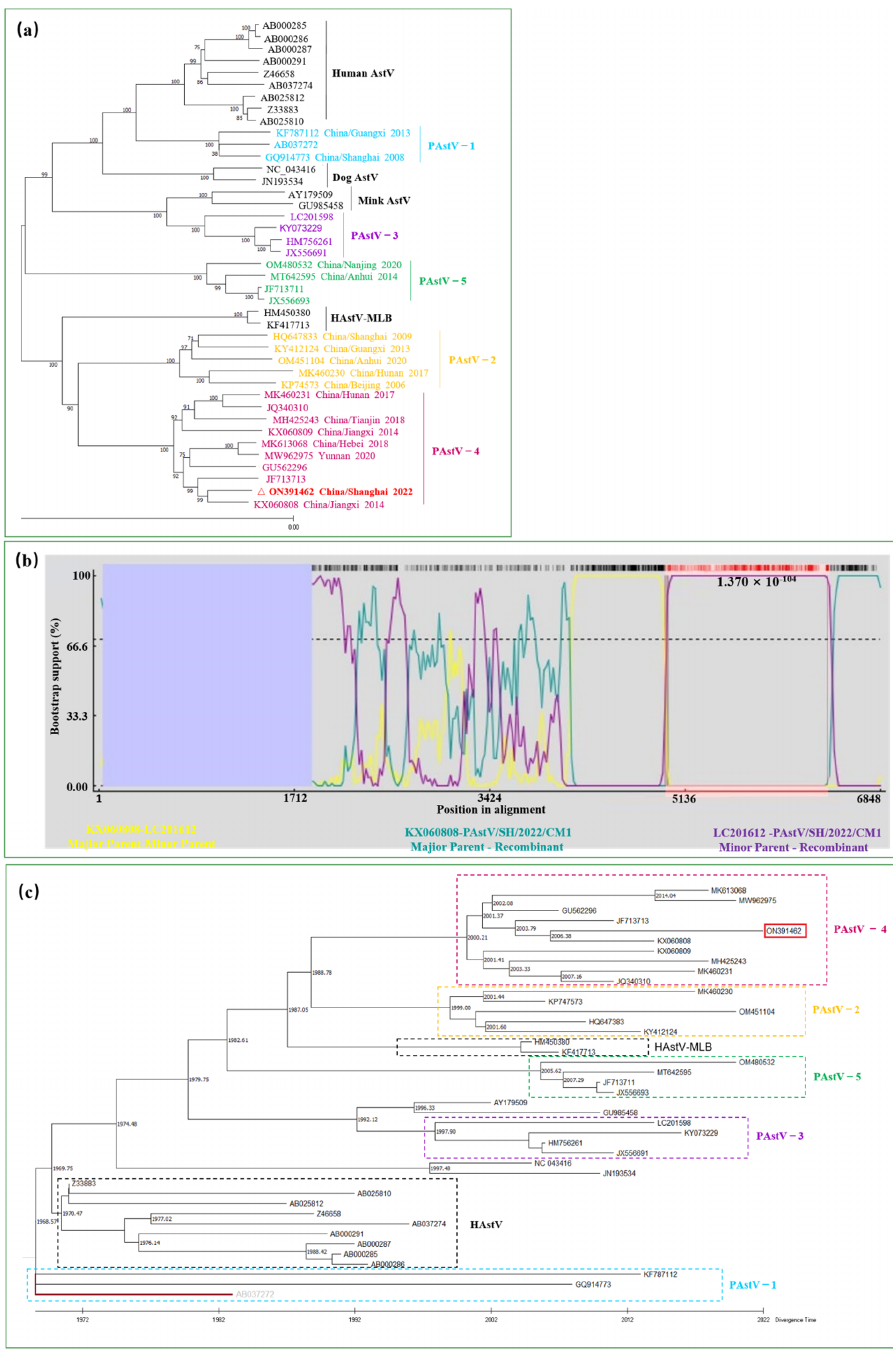
Figure 2. Genetic evolutionary analysis of PAstV/SH/2022/CM1. ( a ) A phylogenetic tree was constructed based on the ORF2 sequences of astroviruses using the maximum likelihood method implemented in MEGA X. ( b ) Viral recombination was further analyzed and the potential recom- binant breakpoints were identified by RDP4.0. BOOTSCAN on the basis of pairwise distance with 100 bootstrap replicates. ( c ) The time tree was calculated in MEGA X where divergence time was inferred by the RelTime with Dated Tips (RTDT) method. The PAstV-1 strain (AB032272) (grey color) was designated as an outgroup taxon and all sequences used the year of sampling dates as the tip dates for calibration constraints. The divergence time of each branch is marked. PAstV-1, PAstV-2, PAstV-3, PAstV-4, and PAstV-5 strains are circled in different colors of dotted